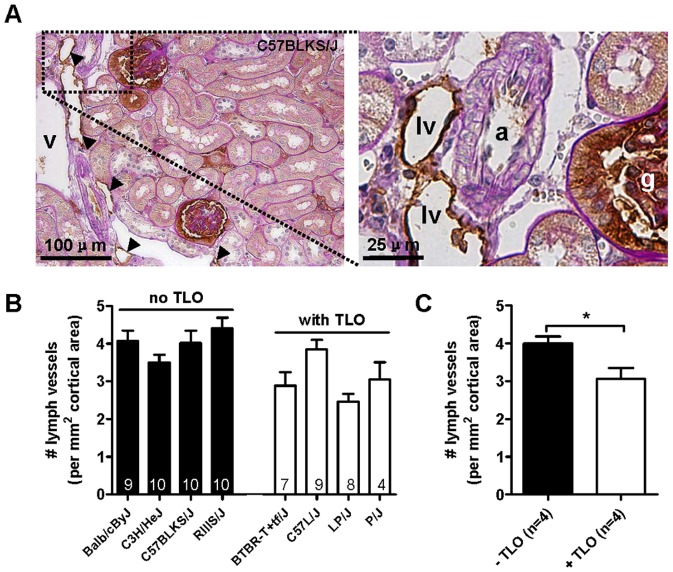
Strains with TLO formation are characterized by reduced numbers of lymph vessels.(A) Representative photomicrograph of peri-arteriolar lymph vessels in a C57BLKS/J mouse kidney (left panel). The right panel shows a high-power magnification of the indicated framed area. Arrowheads indicate podoplanin+ lymph vessels. Abbreviations: a: arteriole; g: glomerulus; lv: lymph vessel; v: vein. (B) The number of podoplanin+ lymph vessels was quantified in selected strains based on the relative absence (BALB/cByJ, C3H/HeJ, RIIIS/J, C57BLKS/J [black bars]) and abundance (BTBR T+ tf/J, C57L/J, P/J, LP/J [white bars]) of TLOs at the age of 20 months. Numbers indicated within each bar represent the number of mice analyzed. (C) The mean number of lymph vessels in the 4 strains without TLOs (BALB/cByJ, C3H/HeJ, RIIIS/J, C57BLKS/J [black bars]) and with TLOs (BTBR T+ tf/J, C57L/J, P/J, LP/J [white bars]) was calculated. Strains with TLO formation had overall significantly lower numbers of lymph vessels compared with strains without TLOs (*P<0.05).